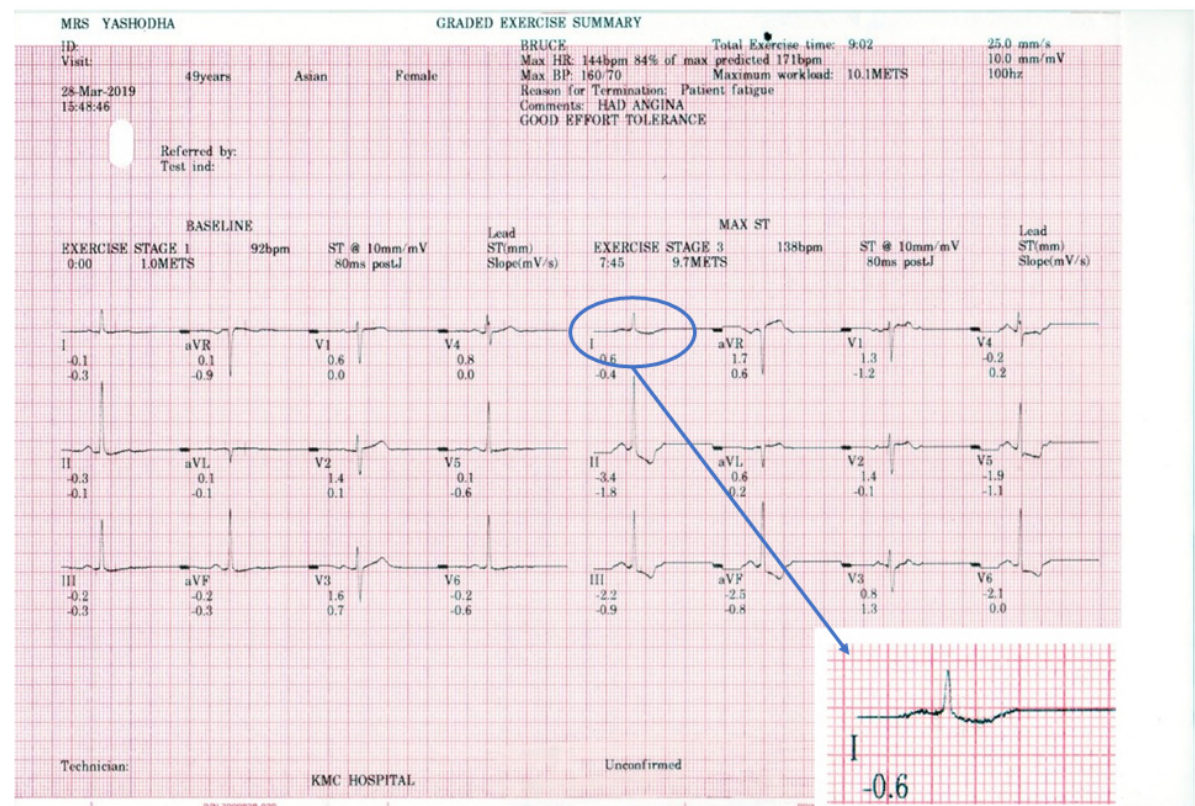
Figure 4. Twelve-lead TMT-ECG ECG report.